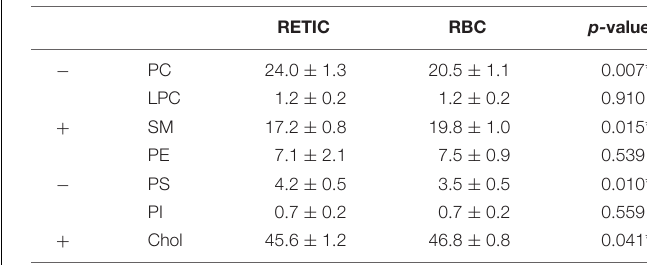
TABLE 3 | Quantification of lipids in the membrane of Retics and RBCs in five independent experiments with five different